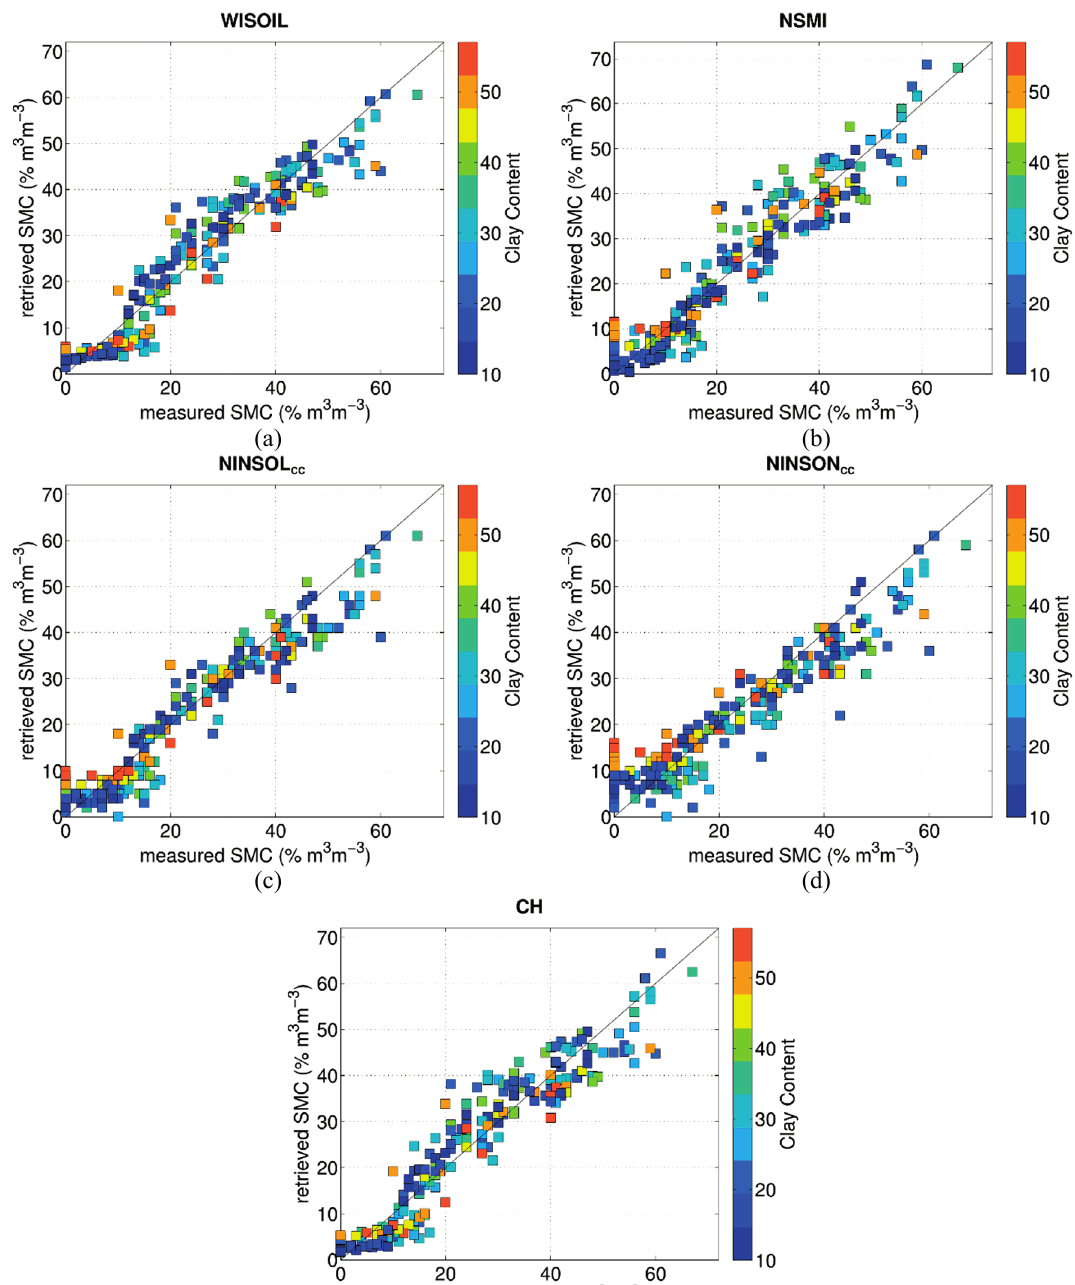
Figure 10. Comparison between measured and estimated SMC. Four criteria are considered: ( a ) WISOIL; ( b ) NSMI; ( c ) NINSOL CC ; ( d ) NINSON CC and ( e ) CH. The color bar indicates the clay content